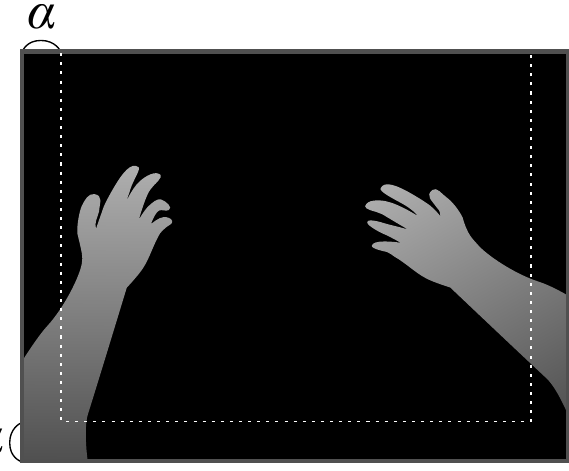
Figure 7. Defining width α to distinguish the closer